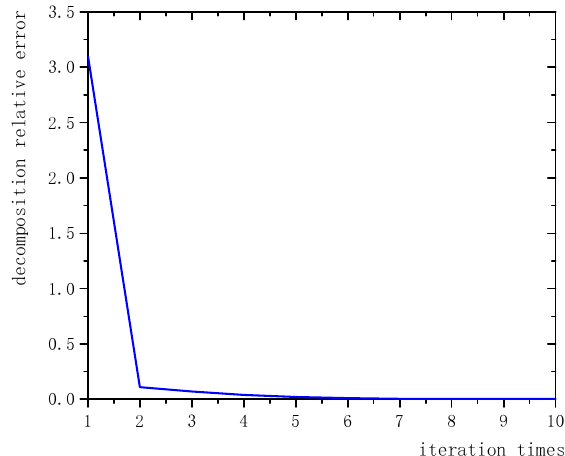
Figure 4. Iteration of the proposed method.